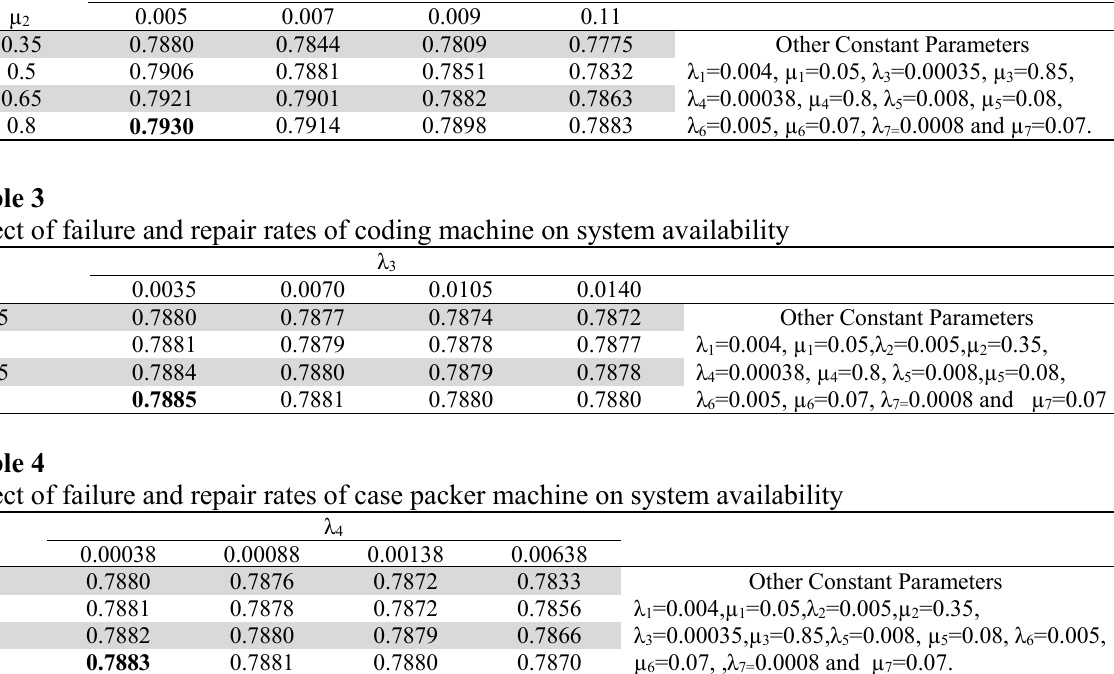
Effect of failure and repair rates of electronic inspection machine on availability of the system λ 2 µ 2